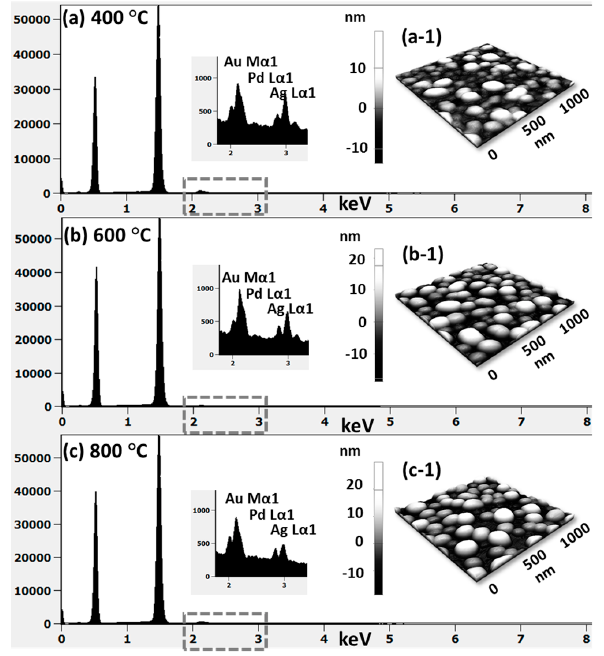
Figure A6. ( a – c ) EDS spectra between 0 and 8 keV of the samples with various temperature as labeled. The initial total film thickness was 6 nm with the composition of 2 nm Au, 2 nm Ag, and 2 nm Pd in a sequential order. In sets highlights the Au M α 1, Pd L α 1 and Ag L α 1 peaks of the samples. ( a-1 – c-1 ) Corresponding surface morphologies of the samples with AFM side-views of 1 × 1 µm 2 .